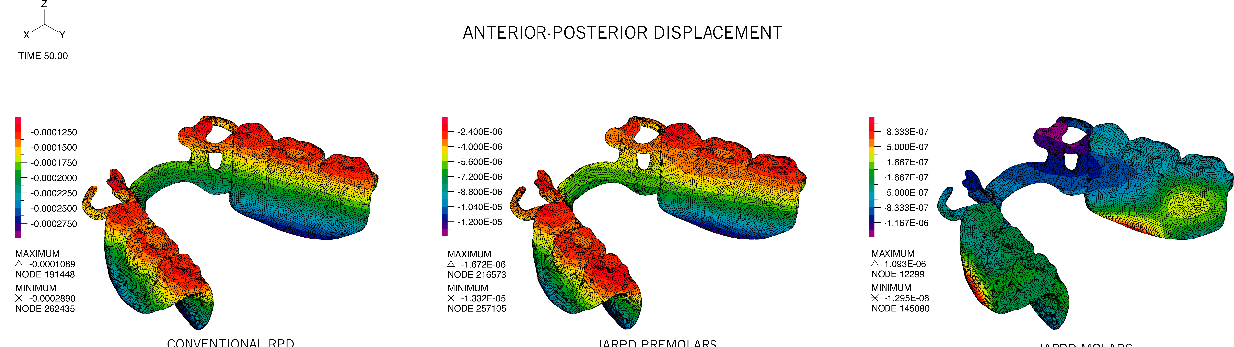
Figure 3. Band plot of the displacement in the Y direction for the three models analysed: CONVENTIONAL Removable partial denture (RPD) ( left ), implant-assisted removable partial denture) IARPD PM ( center ), IARPD MO ( right ). Non- matching colour scales. Homologous bands of the CONVENTIONAL RPD and IARPD PM models have 100 times discrepancy in values.